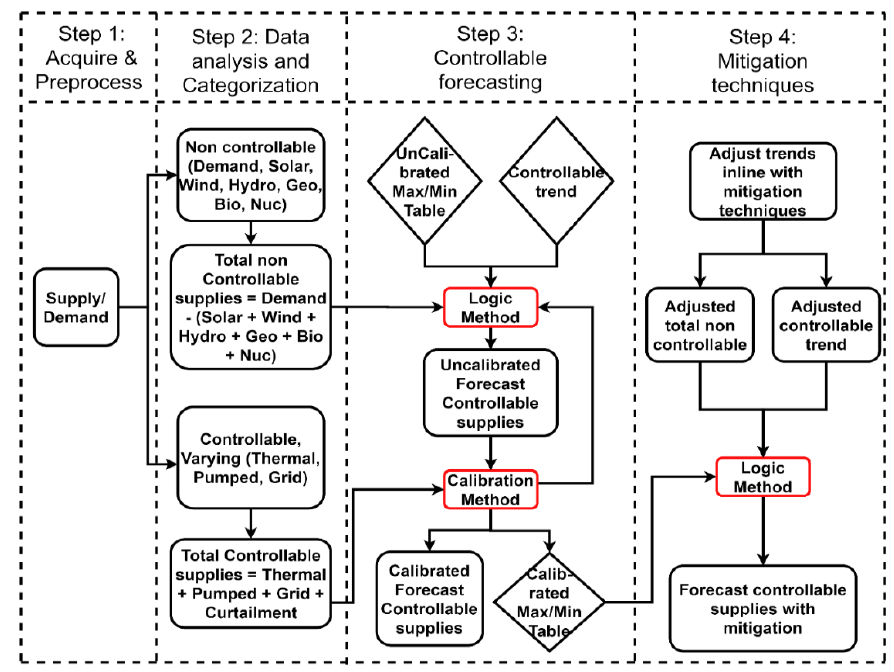
Figure 2. Overall flowchart of the methodology with four steps.